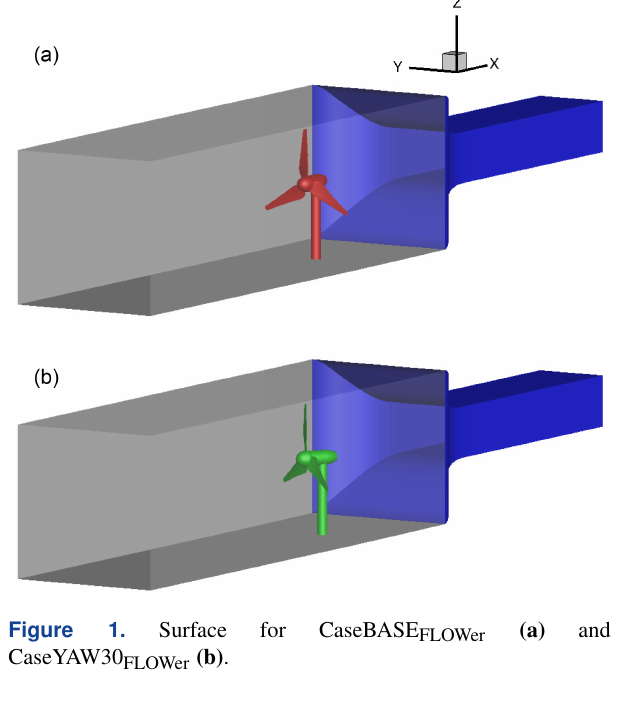
Figure 1. Surface for CaseBASE FLOWer (a) and CaseYAW30 FLOWer (b)